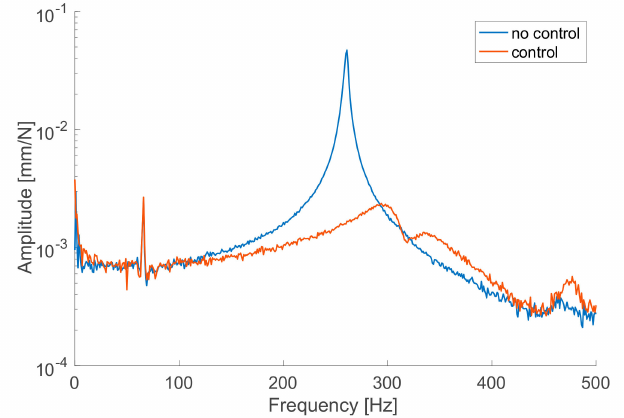
Figure 22. Tooltip FRF in case of control o ff and control